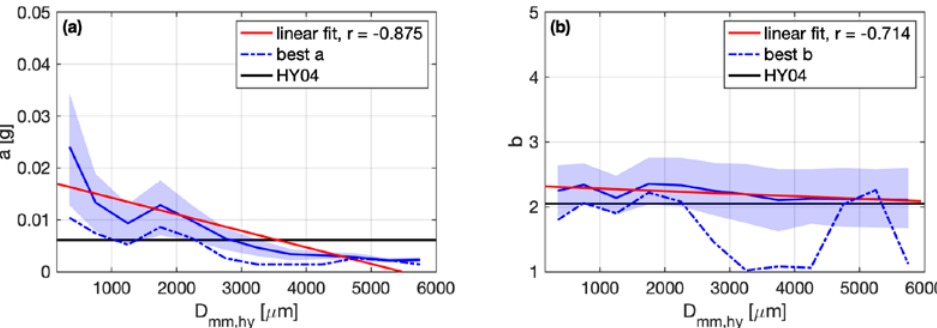
Figure 2. ( a ) Equally plausible solutions of a and ( b ) b determined by the equally plausible surfaces in Figure 1b. The blue solid lines, lower bounds and upper bounds of the blue shading areas represent mean values, 25% and 75% percentiles of a and b solutions respectively in each D mm , hy bins. Blue dashed lines indicate the beat estimate of ( a , b ) that minimizes χ 2 in each D mm , hy bins. Red lines show the linear regression lines of mean values with linear correlation coe ffi cients r shown in legends. Black lines indicate the a and b coe ffi cients of HY04 m–D relationship.